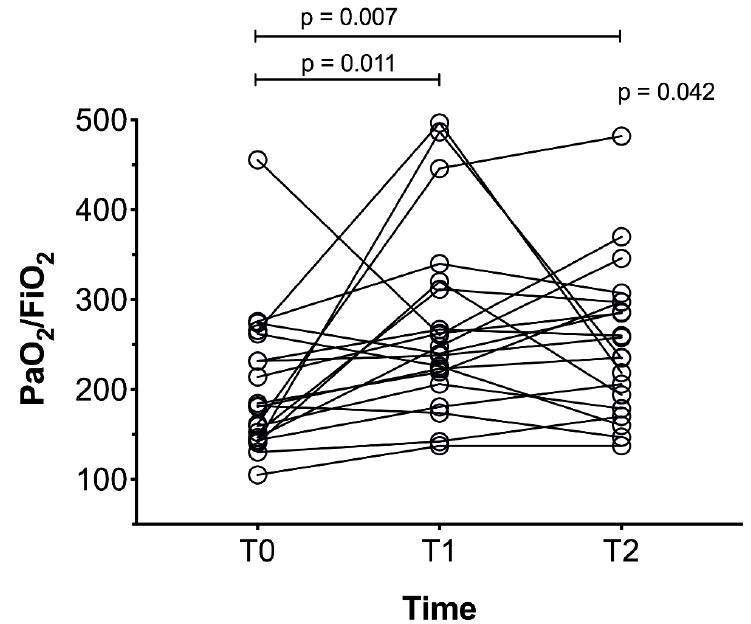
Figure 3. PaO 2 /FiO 2 at the three timepoints. In this figure all the twenty patients are represented as circles. The response of PaO 2 /FiO 2 to RPT is represented by a black line during the study time (baseline (T0), immediately after RPT (T1), and 6 h after chest RPT (T2)). Median PaO 2 /FiO 2 was 181 (105-456), 244 (137-497) and 247 (137-482) at T0, T1, and T2, respectively. Overall median LUS score was 24 (6-28) at baseline, and 20 (13-28) after RPT (MD -1, 95% CI from −6 to 2, p = 0.085), Figure 4.